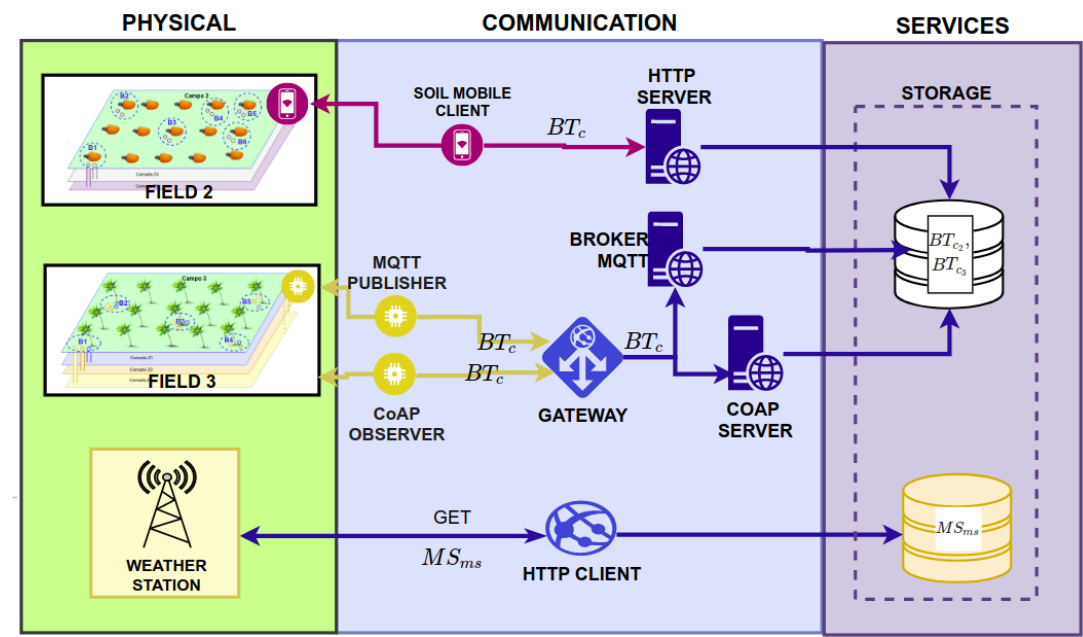
Figure 3. Interaction between the Communication Layer and the Physical and Services